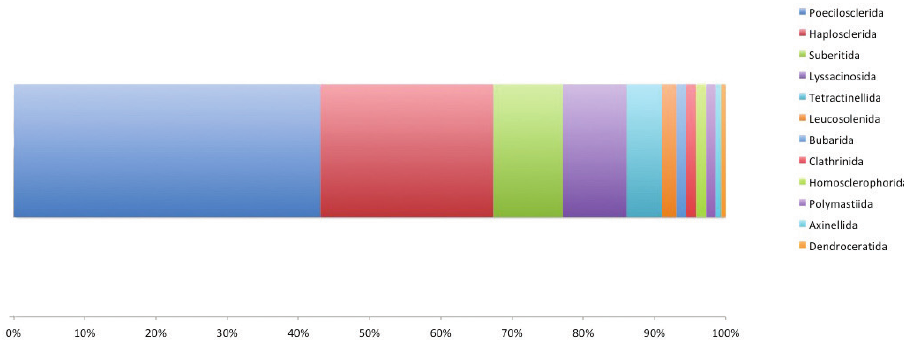
Figure 7. Taxonomic coverage (reported in percentage of specimens per Order) of MNA Porifera collec- tion. Poecilosclerida cover ~43% of the collection specimens, followed by Haplosclerida (~24%), Suber- itida (~10%) and Lyssacinosida (~9%). The remaining orders cover less than